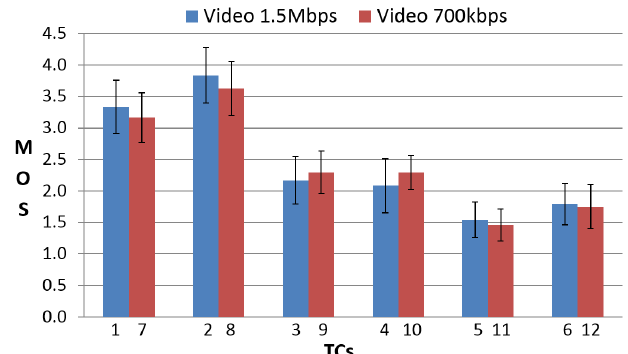
Figure 8. Mean Opinion Score (MOS) results with the 95% CI comparing low and high video qualities being equal in the other conditions.